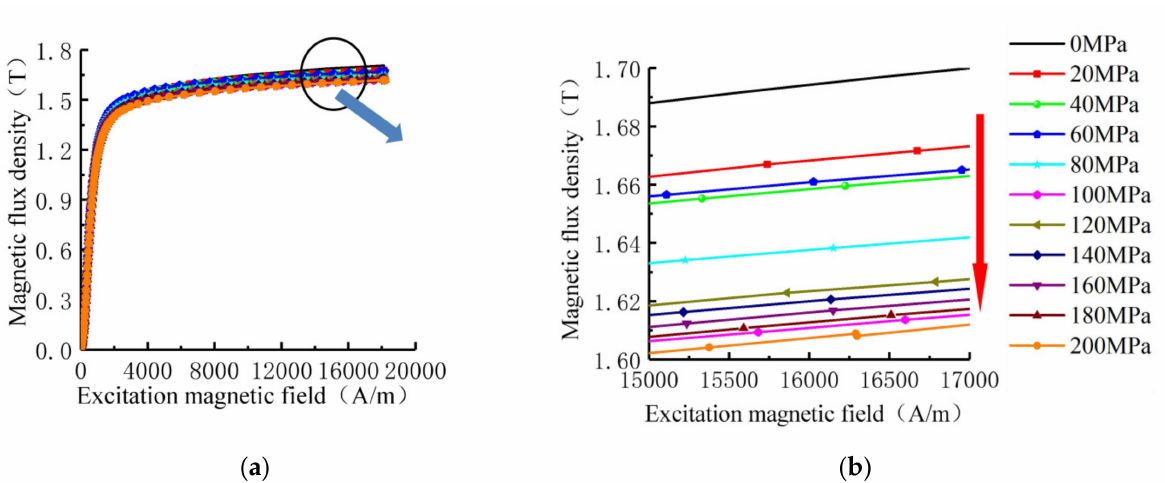
Figure 4. Magnetization curves of X80 steel under different stresses: ( a ) Complete magnetization curve; ( b ) Near saturated region